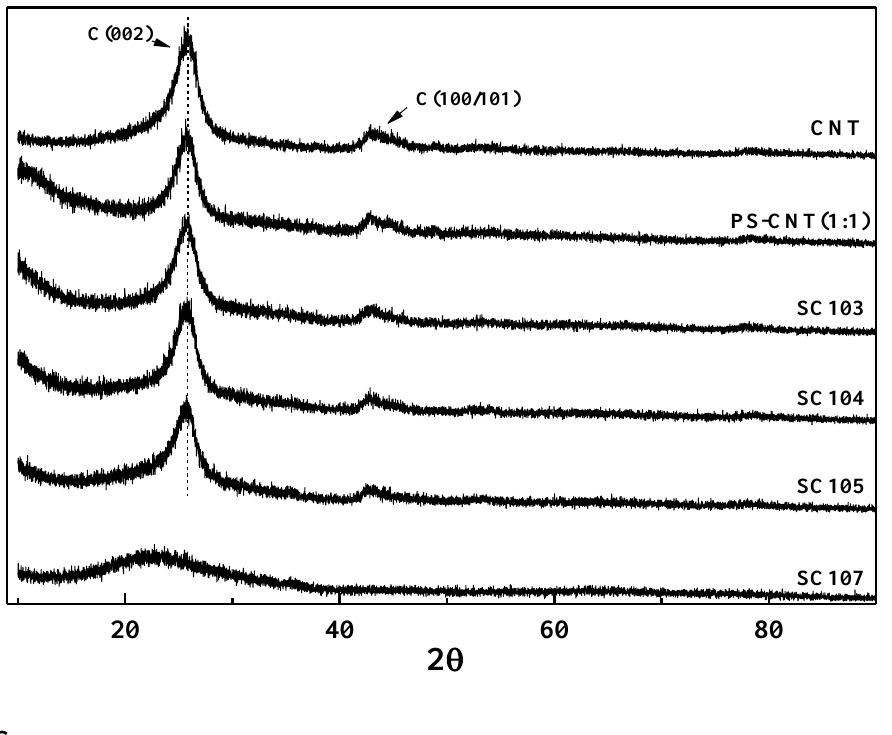
Figure 7. XRD profiles of CNT, PS-CNT and the SiO